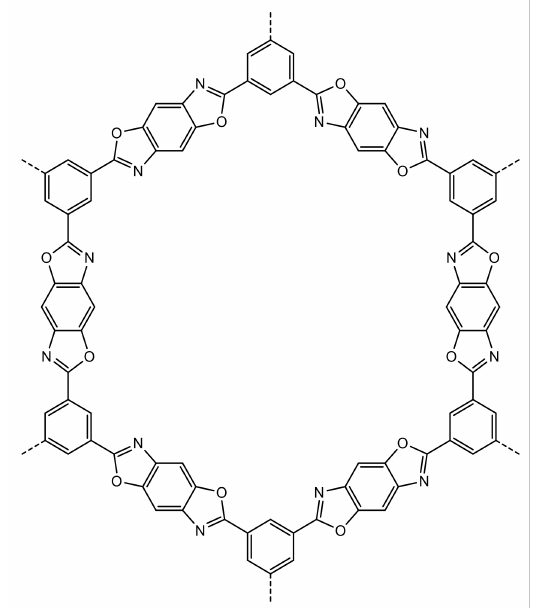
Figure 16. Structure of LZU-190